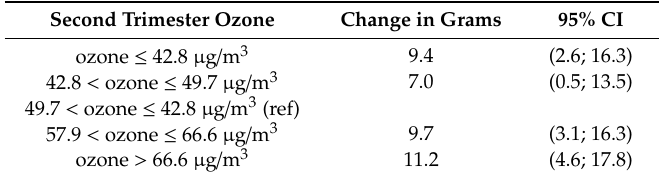
Table A4. Non-linear associations between second trimester exhaust particles and birth